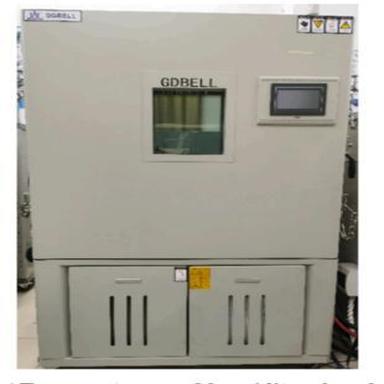
Experimental platform for charge and discharge test.